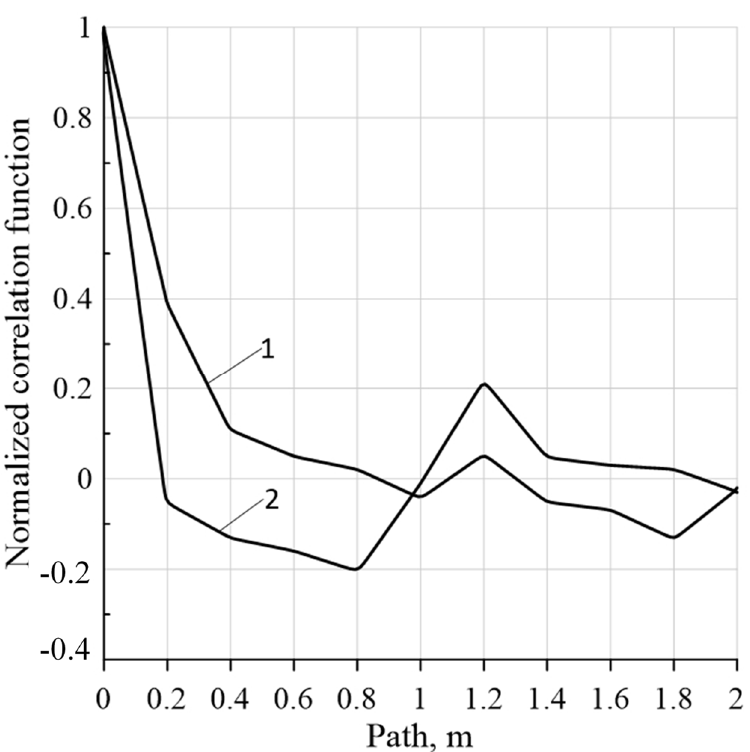
Figure 6. Normalized oscillation correlation functions of the field cross-section after its treatment with the PLN-5-35 plow with skimmers (1) and without them with the PLN-5-35 plow with skimmers (1) and without them (2).